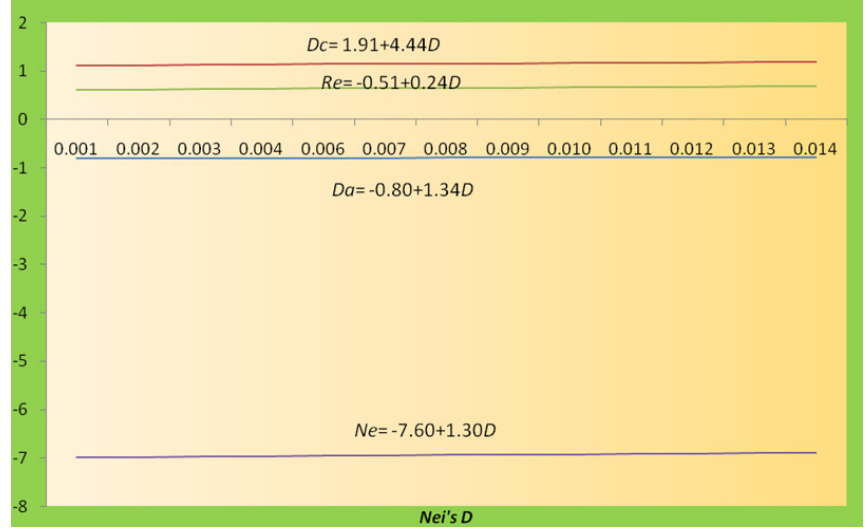
Fig. 1. Linear regression equations showing relationship between Nei’s D with other distance